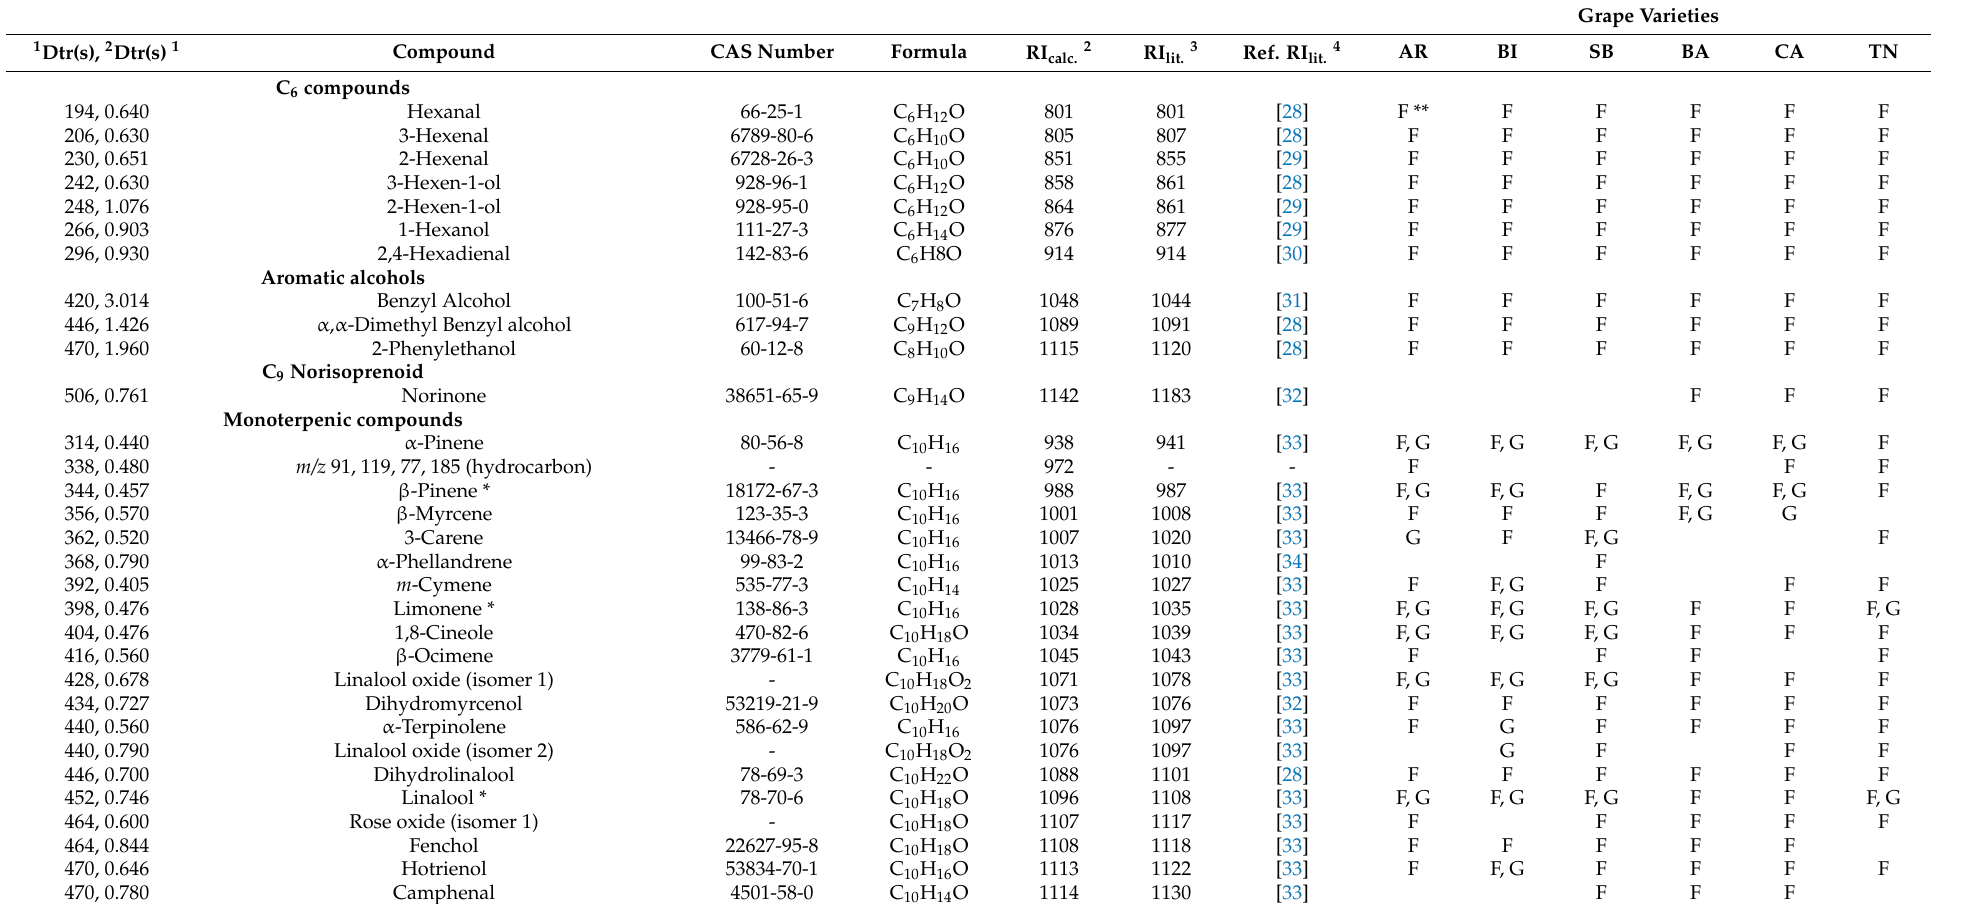
Table 3. Volatile components (free and glycosidically linked ones) determined at technological maturity for Vitis vinifera cv. Arinto (AR), Bical (BI), Sauvignon Blanc (SB), Baga (BA), Castel ã o (CA), and Touriga Nacional, for the three consecutive harvests and three vineyard parcels under study.